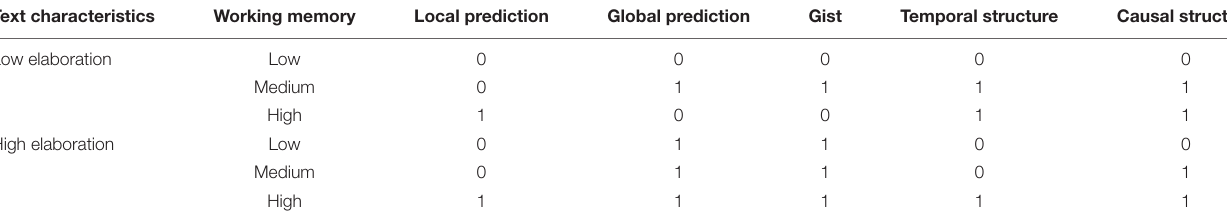
TABLE 7 | Two samples of text recall scores among three WMC groups in two types of texts. Text characteristics